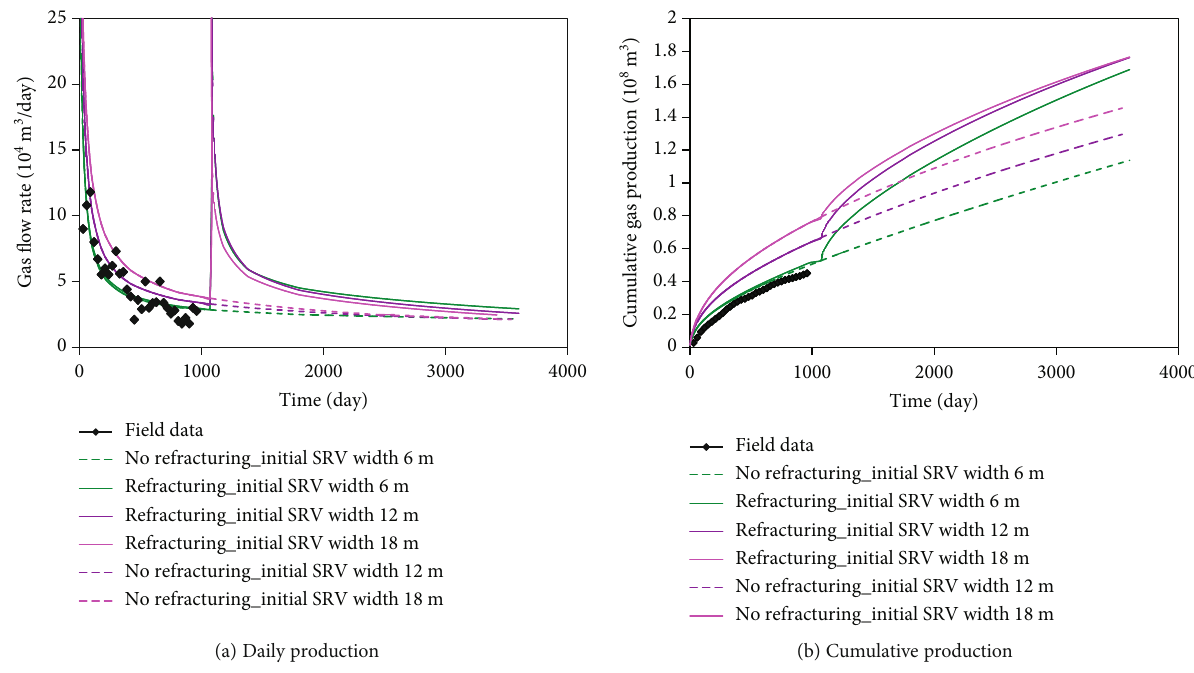
Figure 15: E ff ect of SRV width of initial fracture on daily and cumulative gas productions. Table 5: Production increase percentage with di ff erent SRV widths of initial